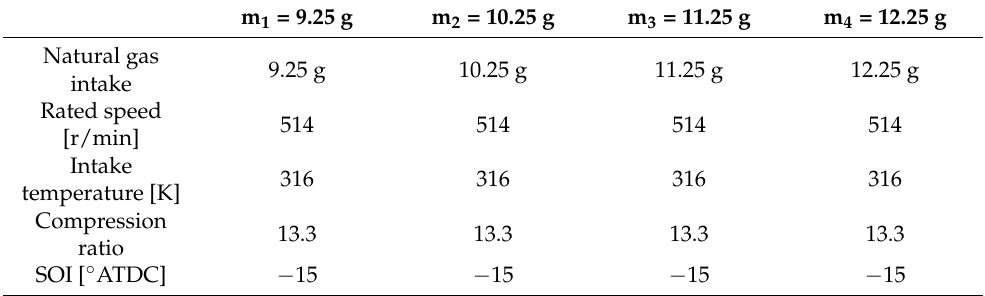
Table 4. The simulation parameters.